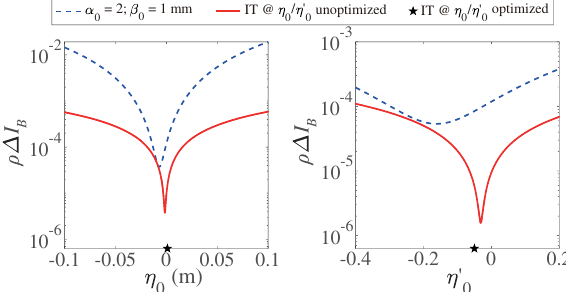
FIG. 4. Longitudinal emittance contribution of the third kind of dipole (C) at various initial dispersions. There exists a minimum in η 0 and η 0 0 both at a certain entrance Twiss and the IT case. By co-changing η 0 , η 0 0 , β 0 and α 0 , the longitudinal emittance contribution Δ I B can be orders of magnitude lower (black star).